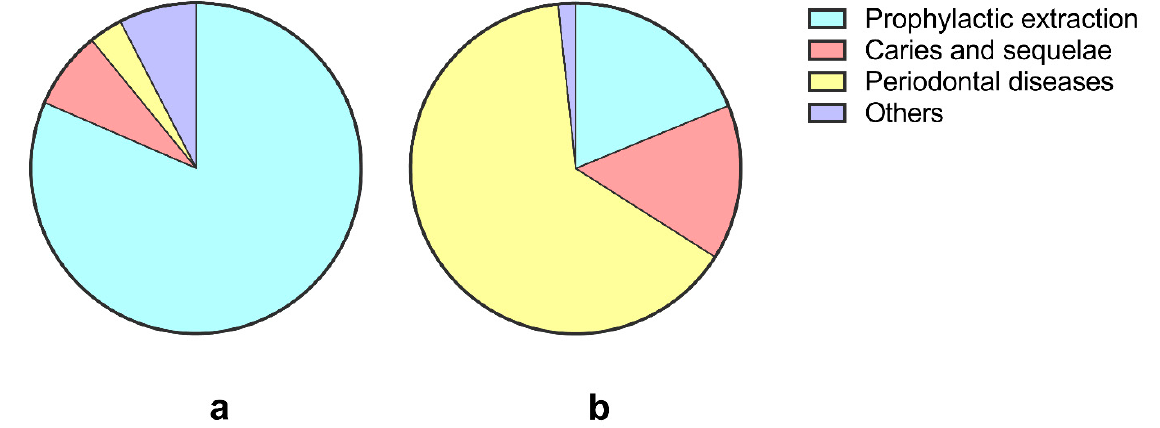
Figure 3. Reasons for extraction of I-M3s ( a ) and N-M3s ( b ) along with adjacent M2 extraction.